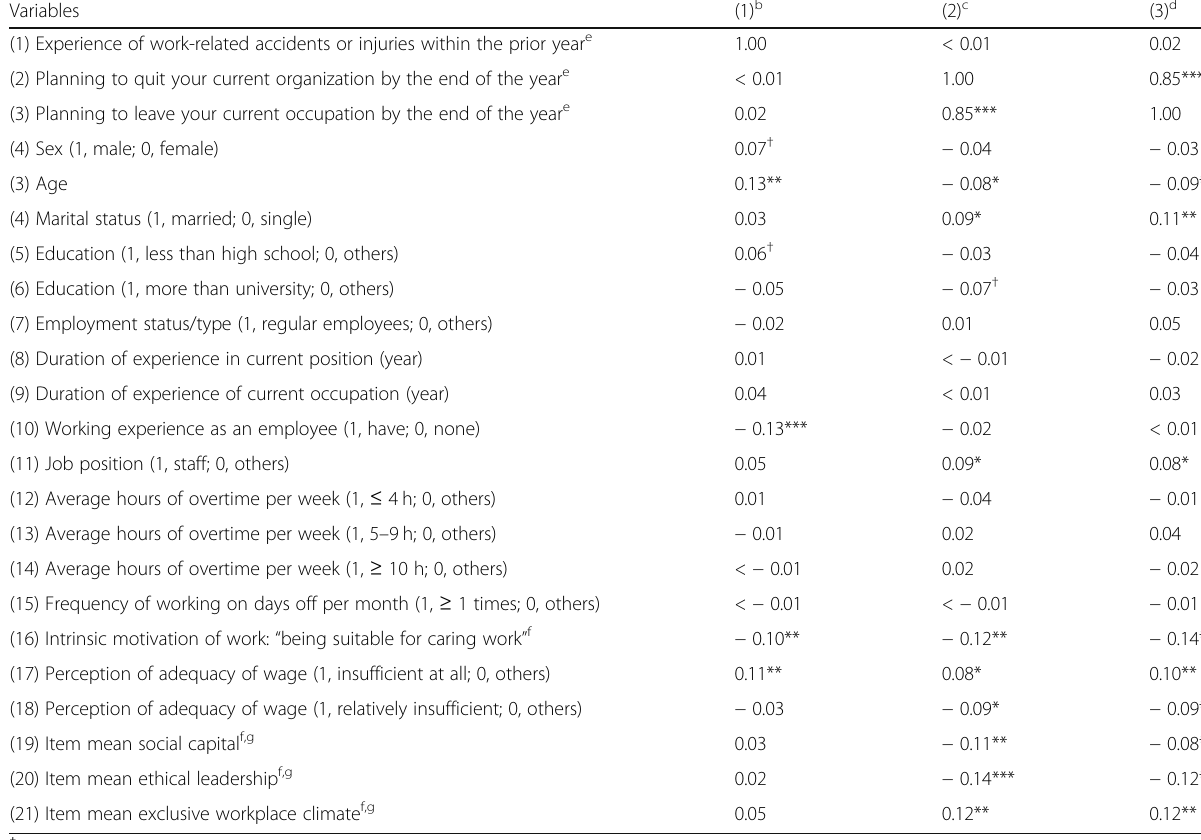
Table 2 Bivariate correlation for all analyzed variables ( n = 667) a